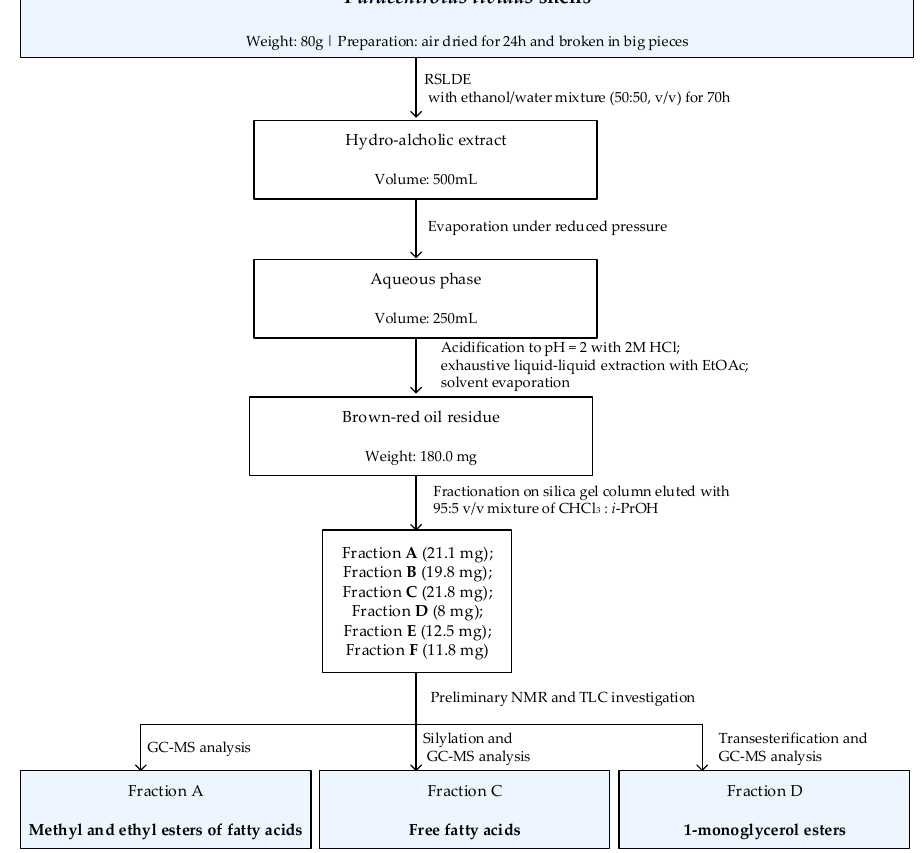
Figure 1. Schematic representation of extraction and purification processes of Paracentrotus lividus shells. Nuclear magnetic resonance (NMR), thin layer chromatography (TLC), gas chromatography-mass spectrometry